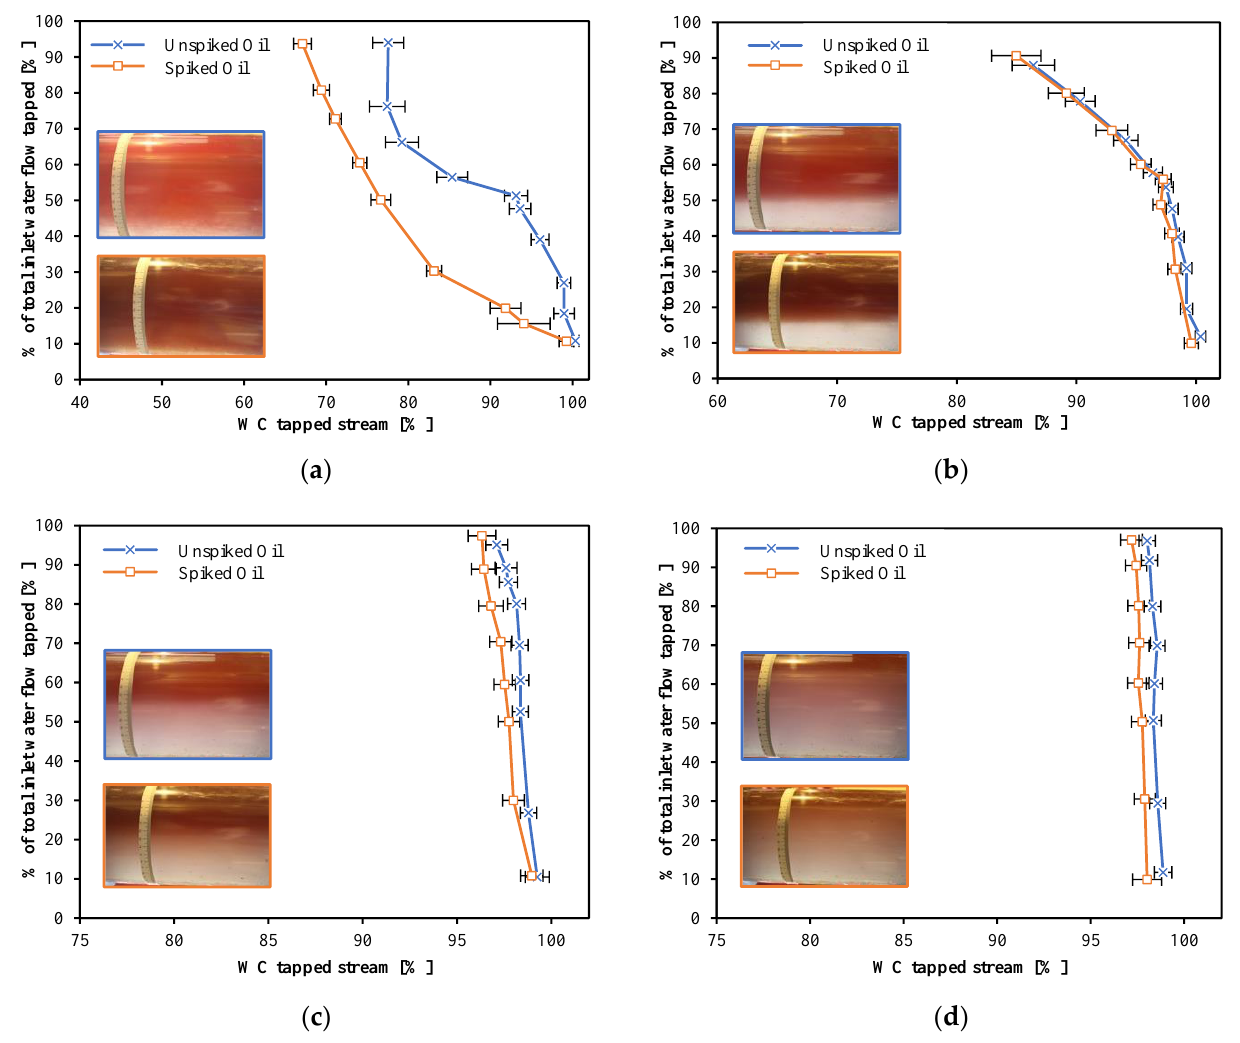
Figure 10. Drainage potential for spiked oil – water and unspiked oil – water with total flow rate of 500 L/min, at WC inlet ( a ) 30%, ( b ) 50%, ( c ) 70%, and ( d ) 90%.